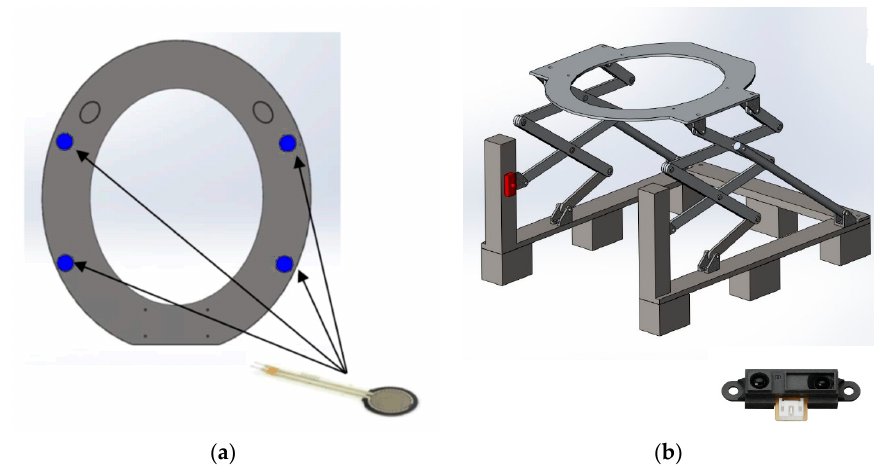
Figure 3. Localization of the sensors: ( a ) four FSR402 sensors; ( b ) IR range sensor located in the front.